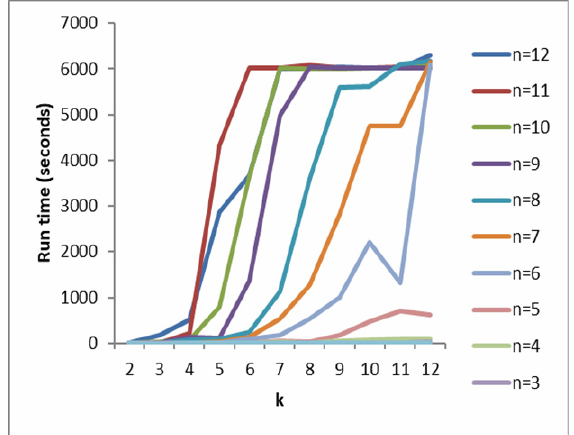
Figure 3. Computational results with bintprog solver